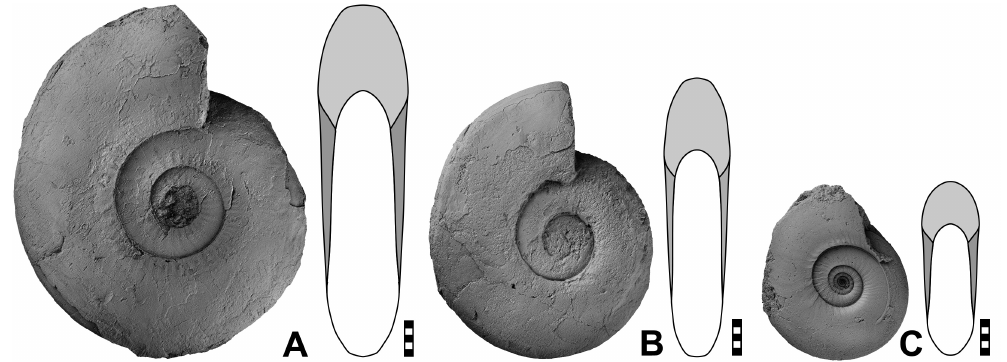
Fig. 11. Ponticeras materni sp. nov. A . Holotype MB.C.22159 (Koch Coll.) from